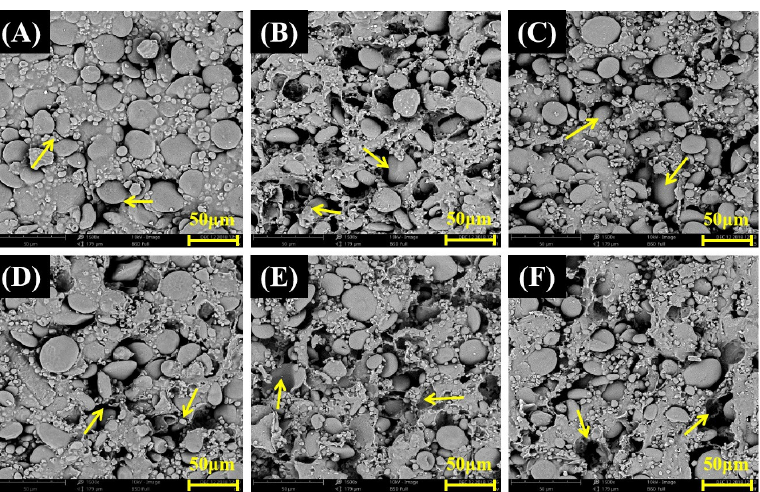
Figure 2. SEM images of the microstructure of noodles made from highland barley flour with different particle sizes (1500×); WFN ( A ), RFN-1 ( B ), RFN-2 ( C ), RFN-3 ( D ), RFN-4 ( E ), RFN-5 ( F ). The yellow arrows in the figure represent the gaps of the internal structure of the noodles.